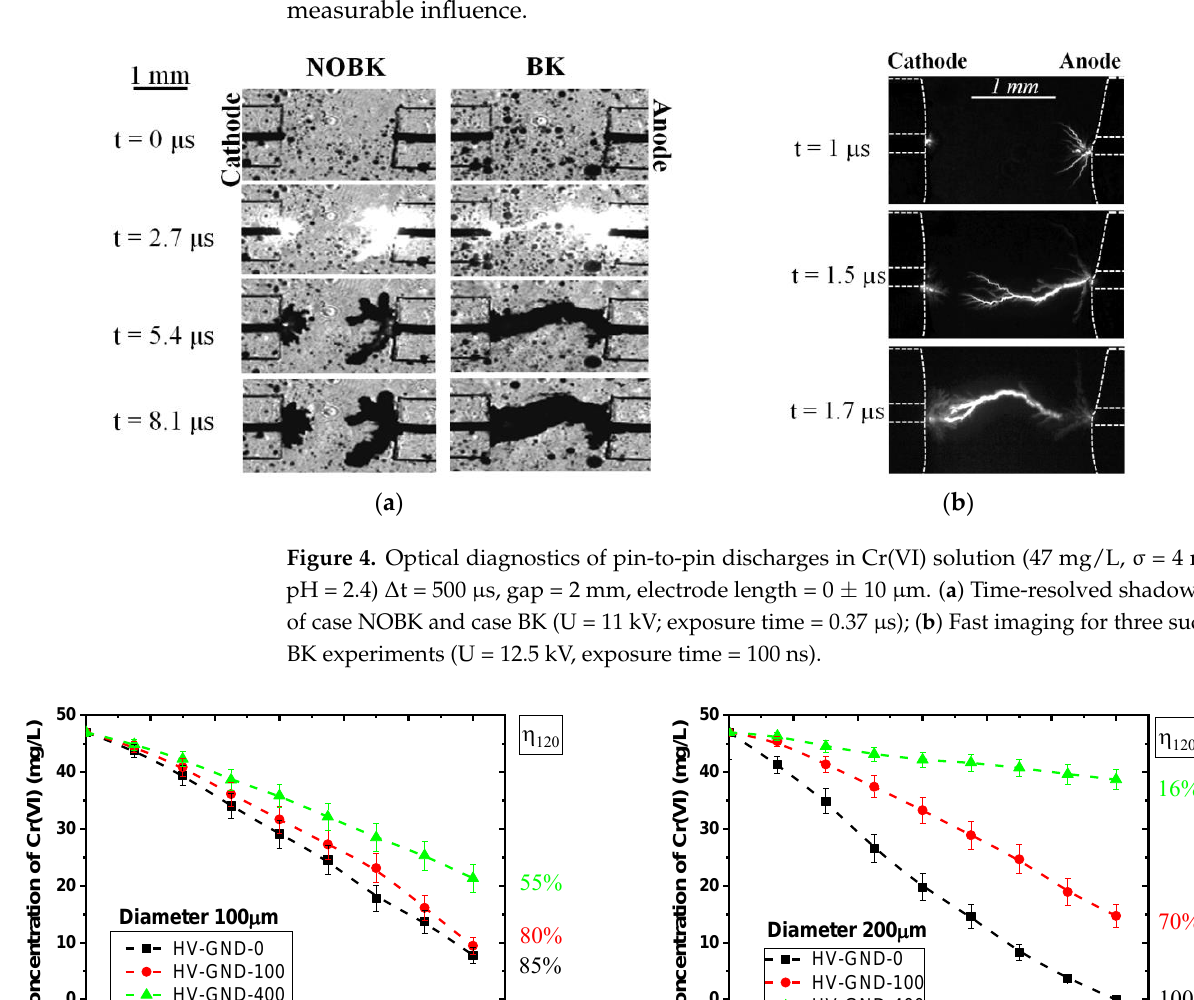
Figure 4. Optical diagnostics of pin-to- pin discharges in Cr(VI) solution (47 mg/L, σ = 4 mS/cm, pH = 2.4) Δt = 500 µs, gap = 2 mm, electrode length = 0 ± 10 µm. ( a ) Time-resolved shadowgraphy of case NOBK and case BK (U = 11 kV; exposure time = 0.37 µs); ( b ) Fast imaging for three successive BK experiments (U = 12.5 kV, exposure time = 100 ns).